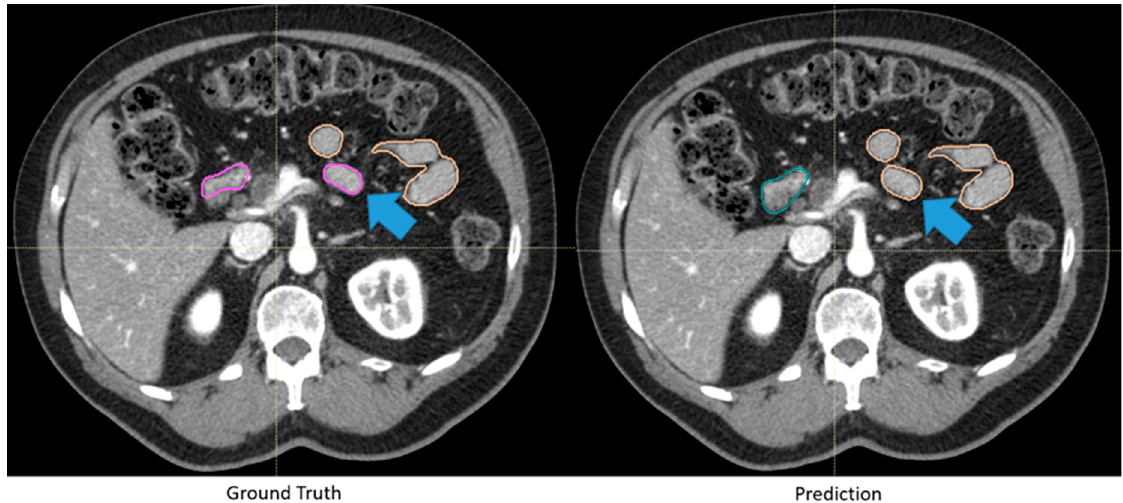
Figure 2. Automatically generated duodenum and small bowel contours with low Dice similarity coefficient (0.61) but were deemed clinically acceptable. Although the automatically generated contour (green: duodenum, yellow: small bowel) deviated from the “ground truth” (pink: duodenum, yellow: small bowel), as highlighted by the blue arrows, the difference was deemed insignificant by clinicians because of the identical dose constraints between the two segmented organs.